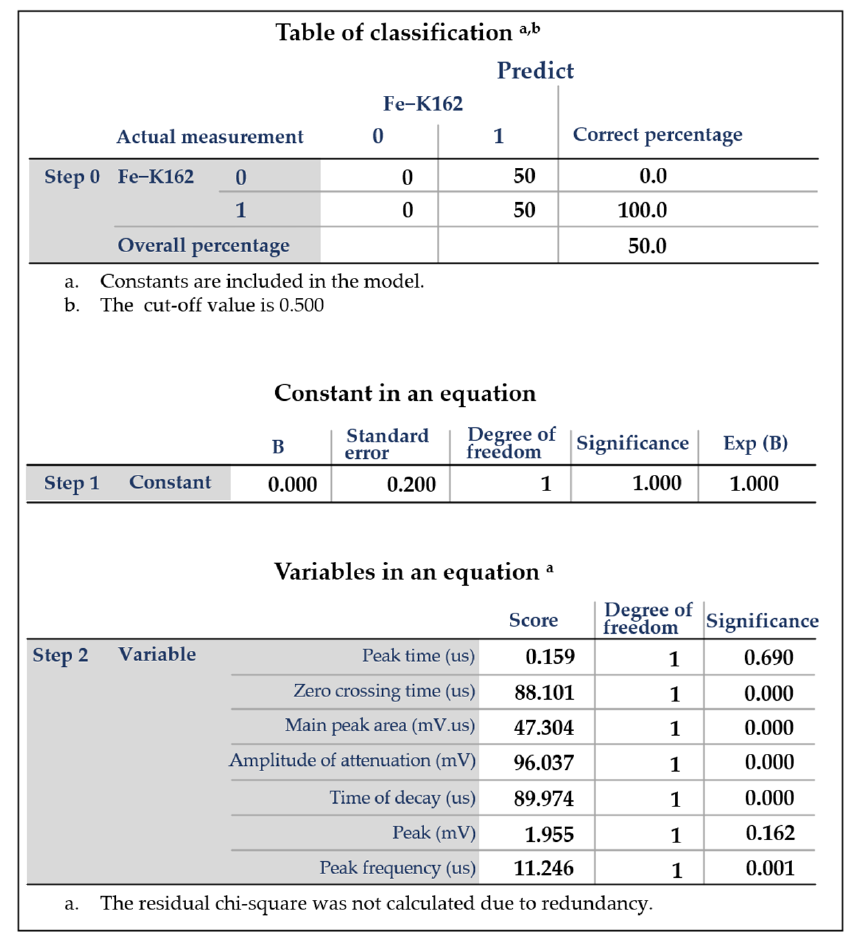
Figure 7. IBM Statistical Product Service Solutions Software statistics binary logistic regression analysis results.